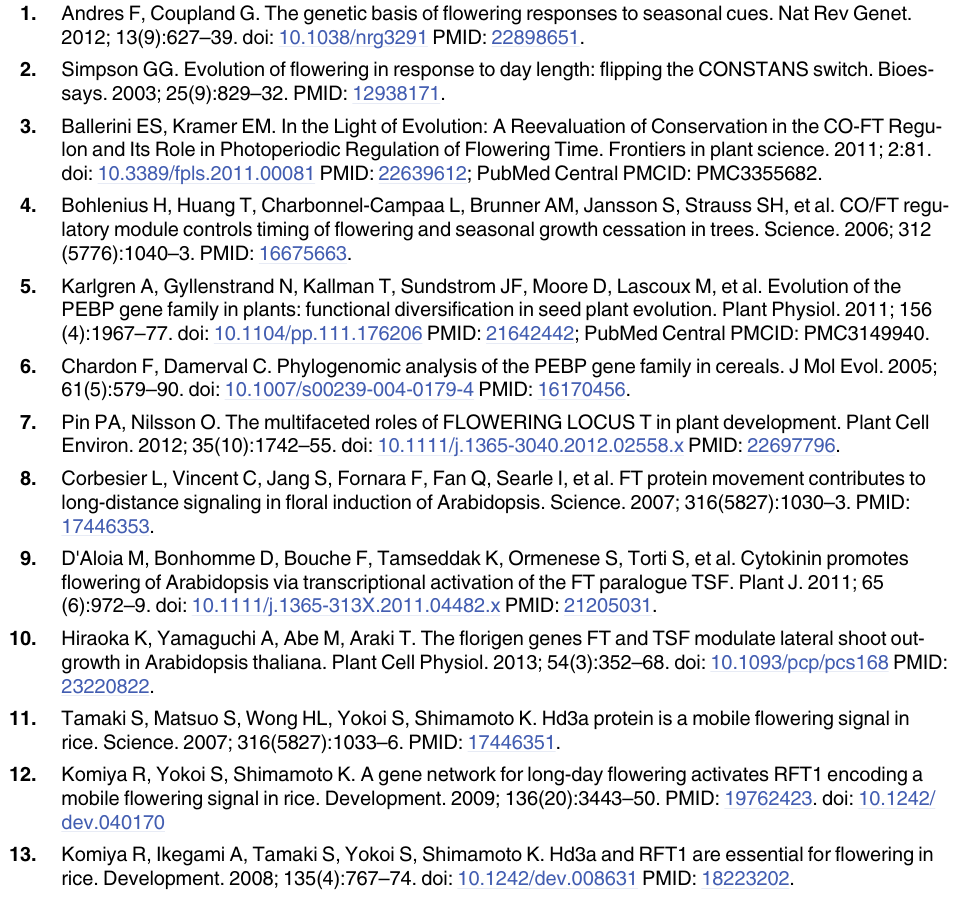
S1 Table. The names of GmFTL s in this study and literature. S2 Table. Sampling organs and date/time for gene expression analysis of circadian. S3 Table. The list of primers used in this